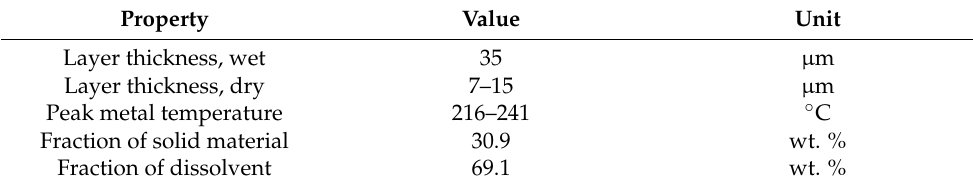
Table 2. Properties of the adhesive agent, Köratac